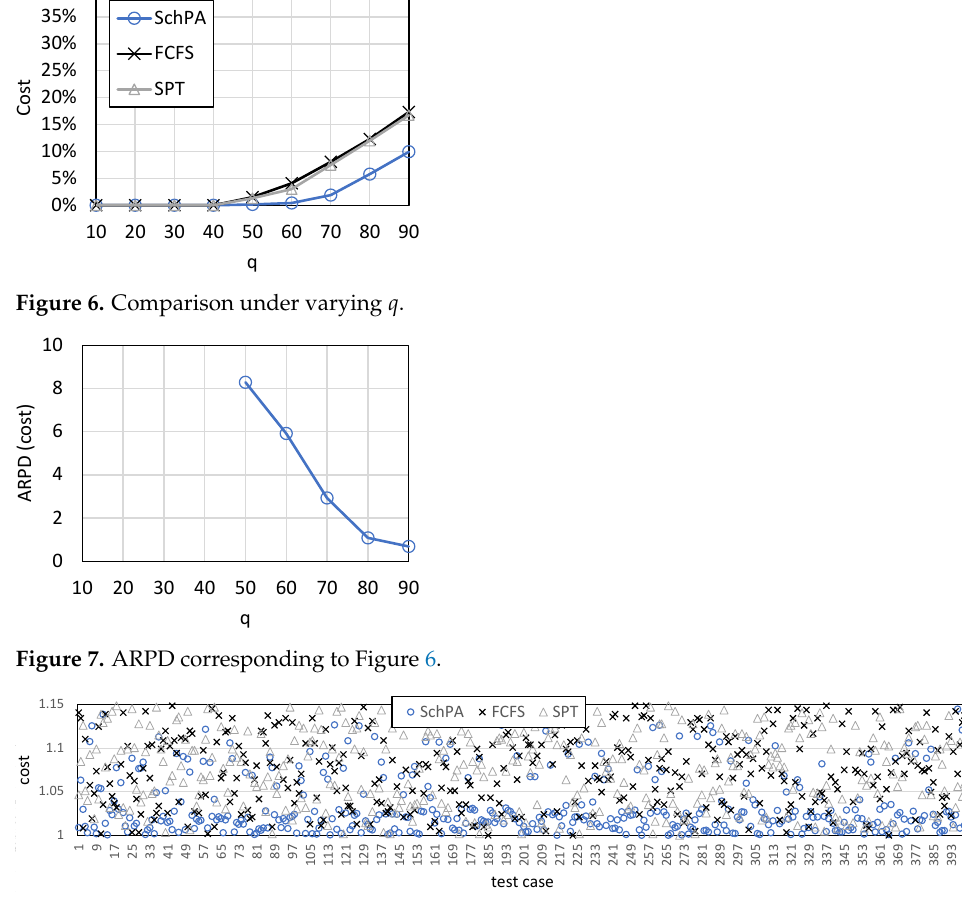
Figure 8. Order distribution.